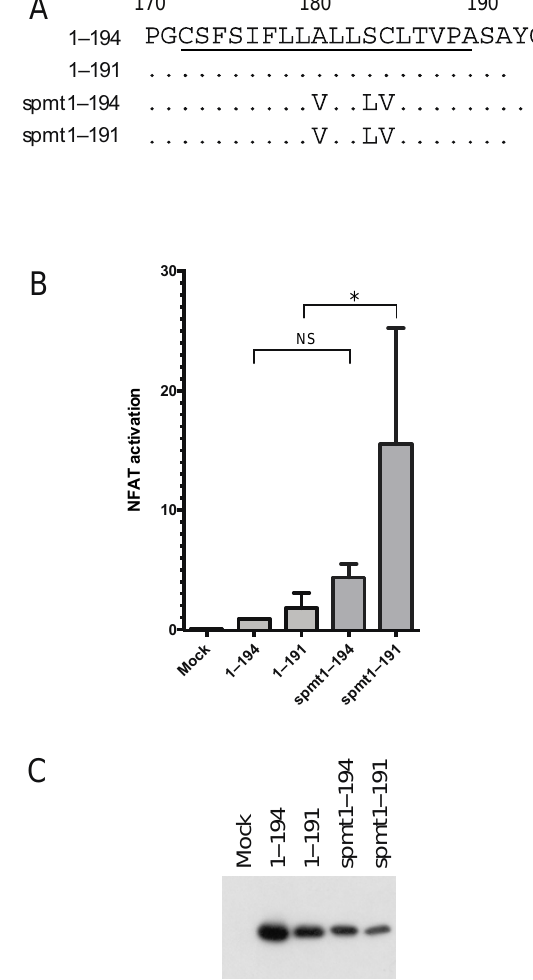
Figure 4. Analysis of the transmembrane region of HCV C for activation of Ca 2+ /NFAT. ( A ) A schematic map of the C-terminal part of HCV C D3. Amino acids in the transmembrane region are underlined. The positions of amino acid substitution in the spmt mutants are indicated. ( B ) Activity of the HCV C transmembrane mutants. Relative transcriptional activity of the spmt mutants was determined